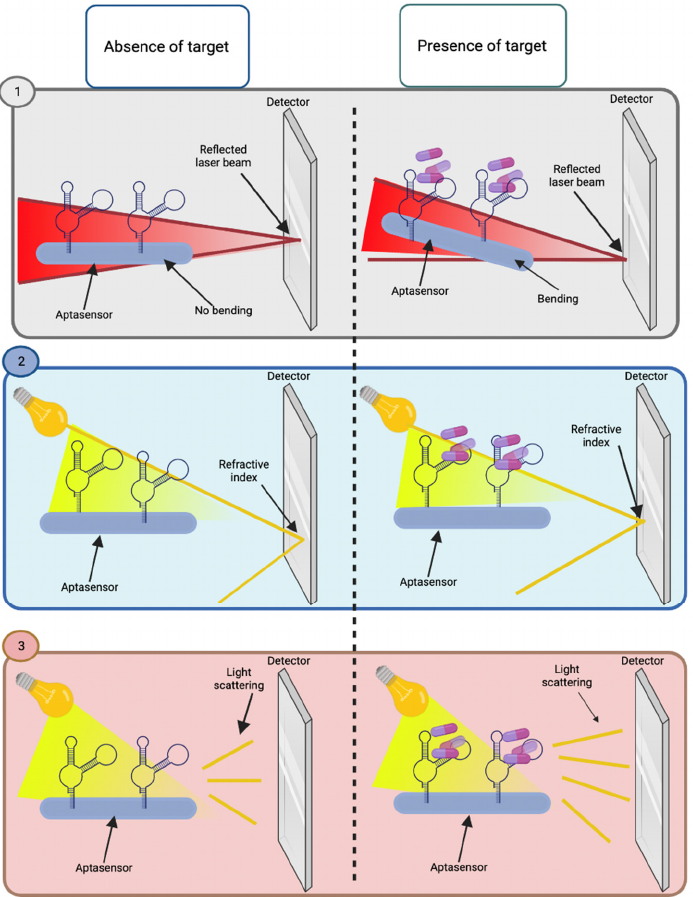
Figure 7. Schematic representation of the different types of optical-mass aptasensors and their operation in the absence and presence of the target. ( 1 ) The cantilever array aptasensor consists of aptamers immobilized on its surface; in the absence of the target, no bending or change in the laser beam reflected is detected. In contrast, when the target is presented, the detector identifies bending and a change in the position of the reflected laser beam. ( 2 ) Surface plasmon resonance (SPR) aptasensor consists of immobilized aptamers; in the presence of the target, a change in the refractive index is identified by the detector, which is not detected in the absence of the target. ( 3 ) Surface-enhanced Raman scattering (SERS) consists of aptamers immobilized on the surface of the aptasensor, which detects light scattering after the input of incident light. No changes are observed in the absence of the target, contrary to when the aptamers interact with their targets. Created with Bio- Render.com.